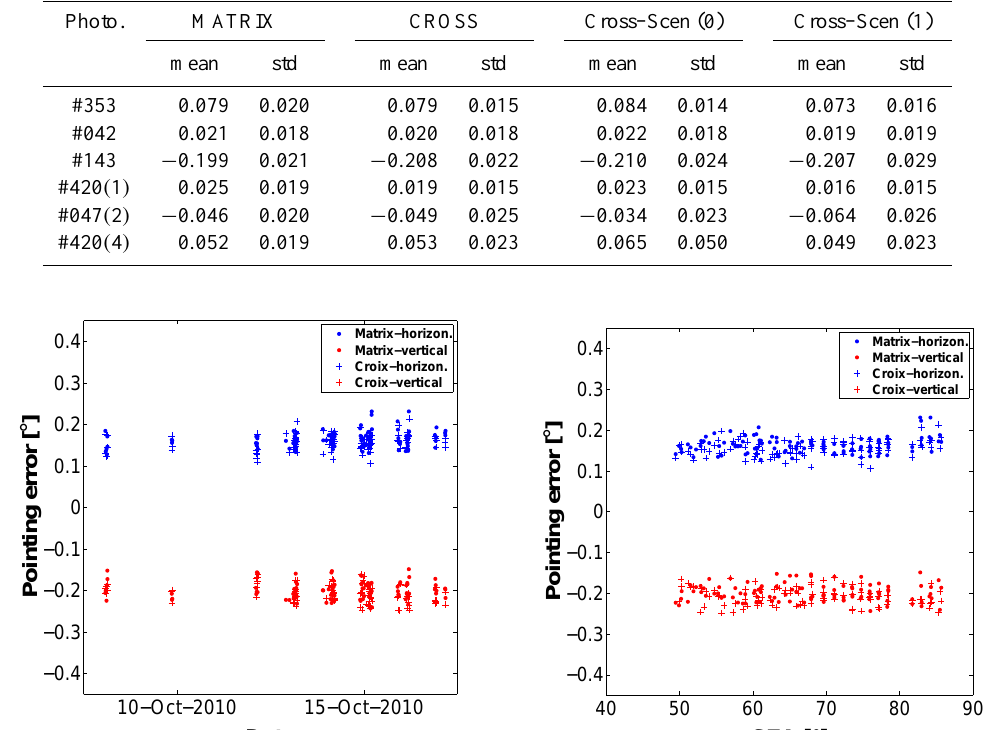
= ξ ϕ sin( θ s ) ) and vertical pointing error ( Θ ξ ϕ